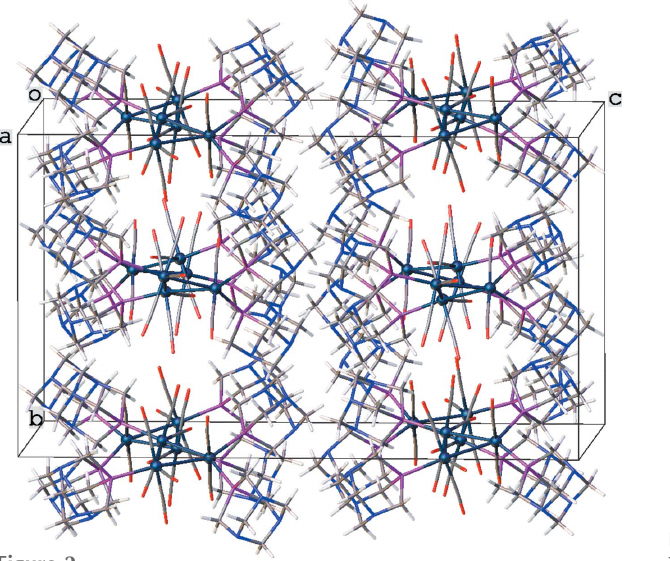
Figure 2 Packing of the molecules viewed approximately along the a axis.